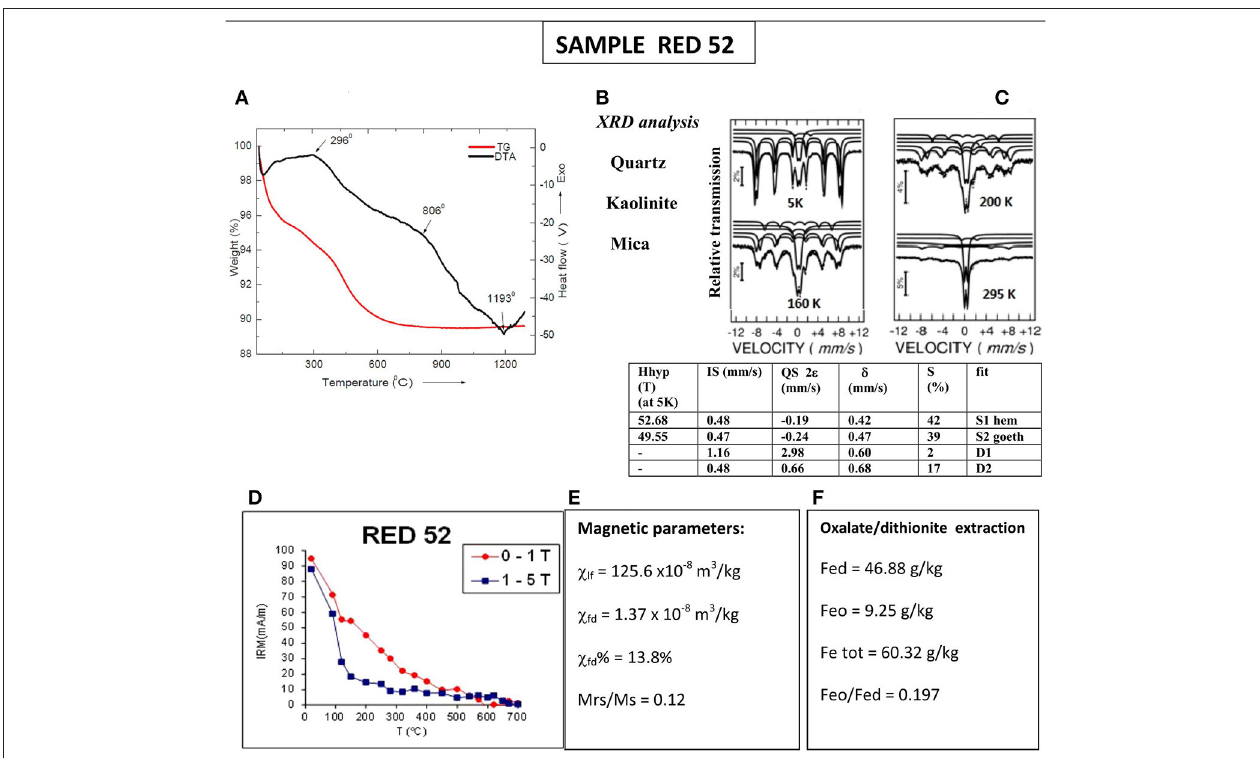
FIGURE 4 | Mineralogical and mineral magnetic characterization of sample RED52. (A) thermogravimetry and differential thermal analysis; (B) quantitative XRD analysis; (C) Moessbauer analysis at 5K with parameters listed in the Table: Hhyp, hyperfine field; IS, isomer shift; QS, quadrupole splitting; δ , hyperfine splitting; S%, relative area; (D) stepwise thermal demagnetization of 2-component IRM (soft and hard), acquired at room temperature; (E) magnetic susceptibility data—bulk low-field susceptibility ( χ ), frequency dependent susceptibility ( χ fd ), and percent frequency dependent magnetic susceptibility χ fd%; (F) extractable Fe: